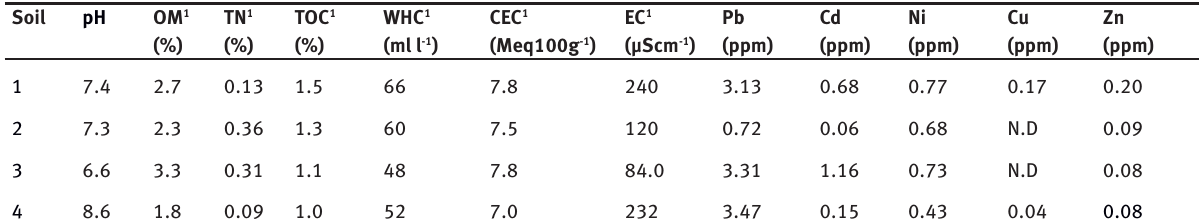
Table 1: Physical and chemical characteristics of soil samples.